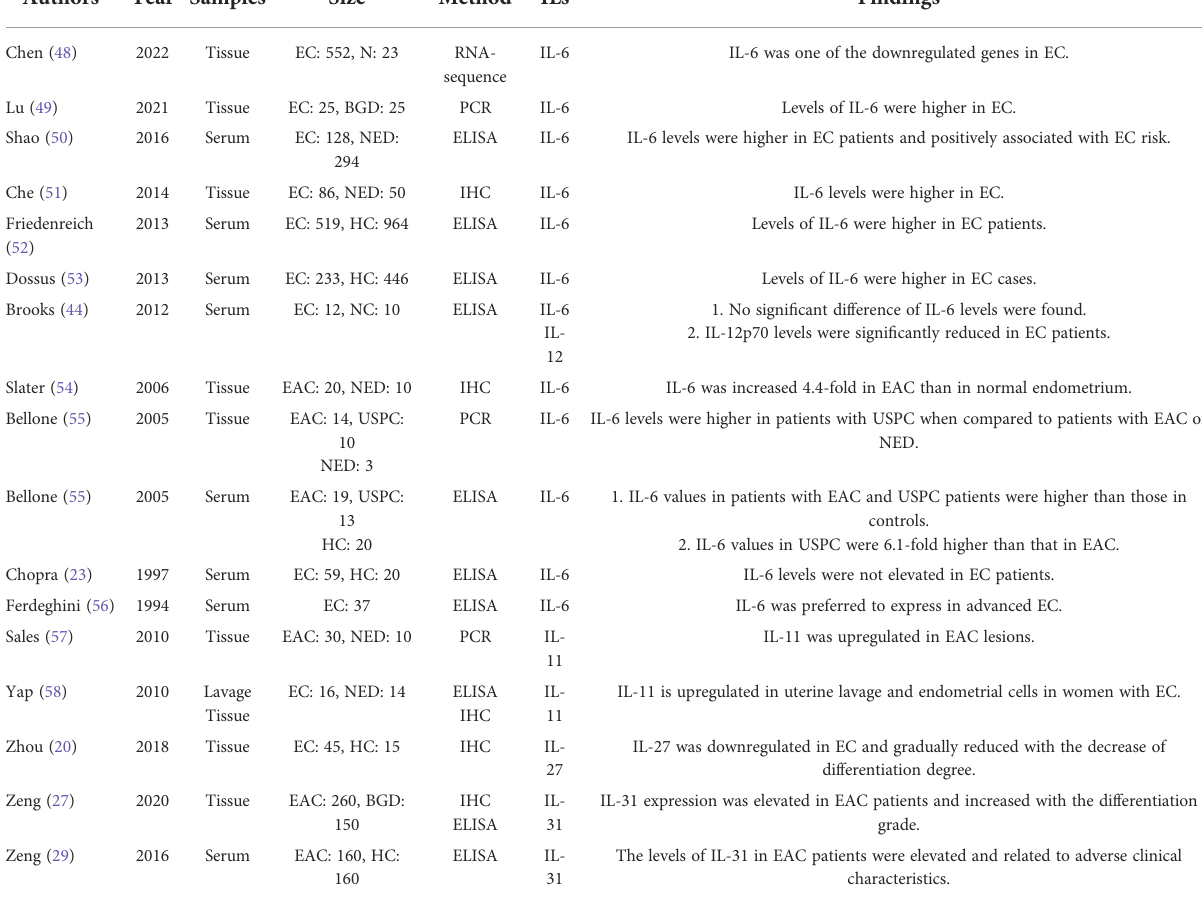
TABLE 2 The expression of IL-6/12 family in